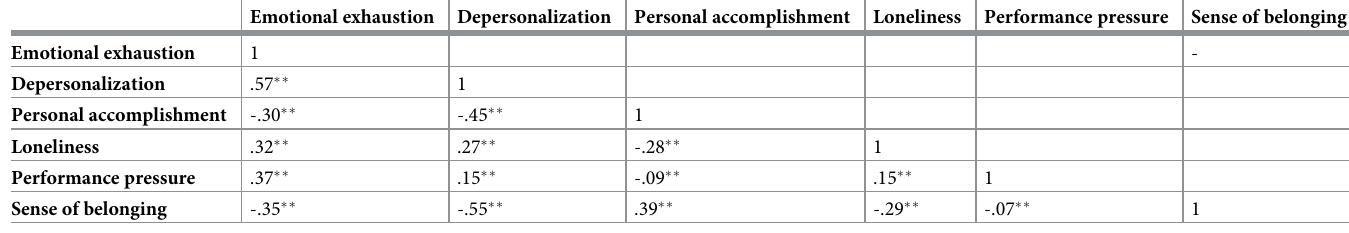
Table 2. Correlations (N = 3,141).